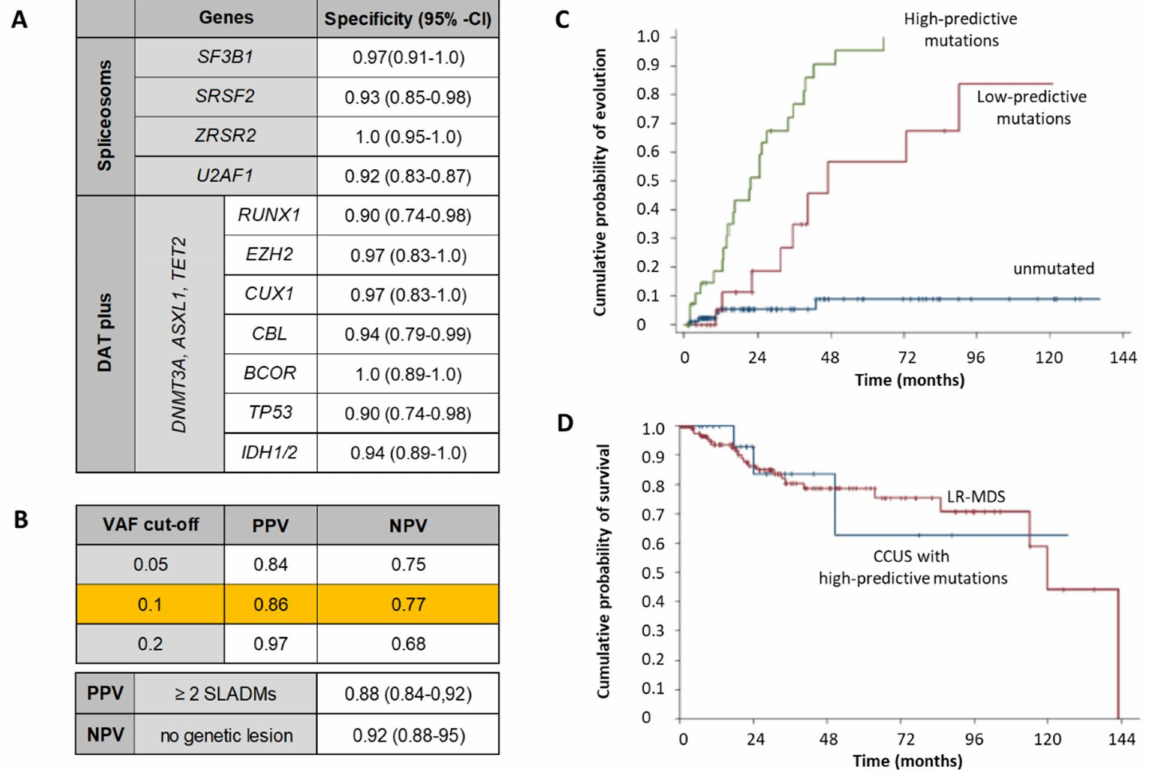
Figure 2. Predictive mutations for myeloid malignancies (adapted from [53]). ( A ) Higher-risk SLADMs (spliceosome genes and DAT plus mutations) with their specificity for development of myeloid malignancy over 5 years. ( B ) Variant-allele frequency (VAF) cut-offs with their corresponding positive and negative predictive values (PPV, NPV) for evolution to myeloid malignancy over 5 years. PPV and NPV at the bottom of the table are represented for a cut-off VAF at 0.1. ( C ) Cumulative probability for evolution to myeloid malignancy for high- (green), low-predictive (red) and unmutated (blue) individuals. ( D ) Cumulative probability of survival for individuals with clonal cytopenia of undetermined significance (CCUS) with high-predictive mutations (blue) and lower-risk MDS (red: